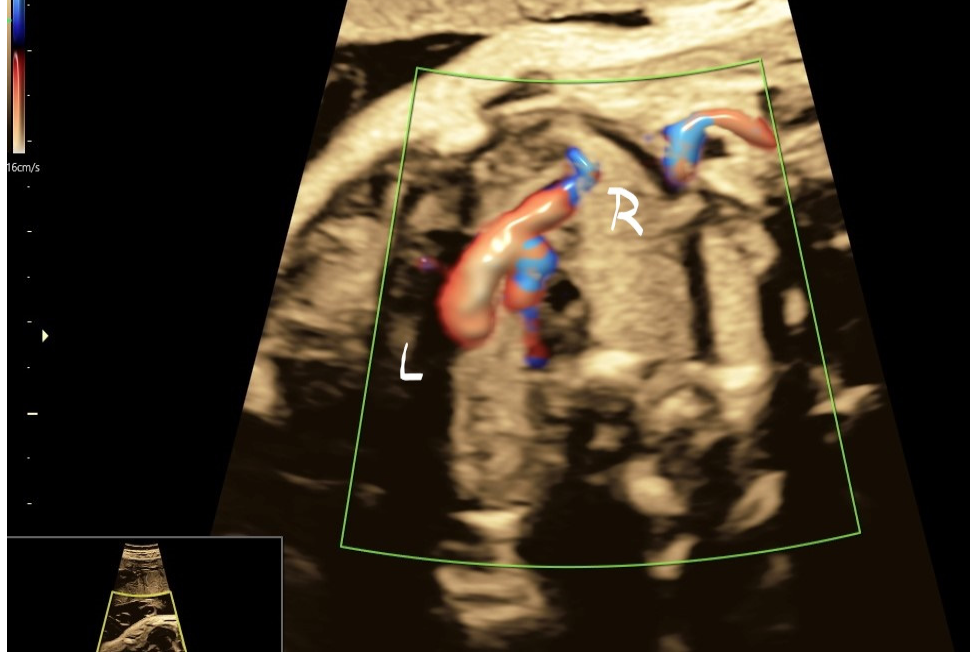
Figure 6. The same case as above, red dot showing a dilated coronary sinus. Figure 7. The same case as above, red dot showing a dilated coronary sinus.